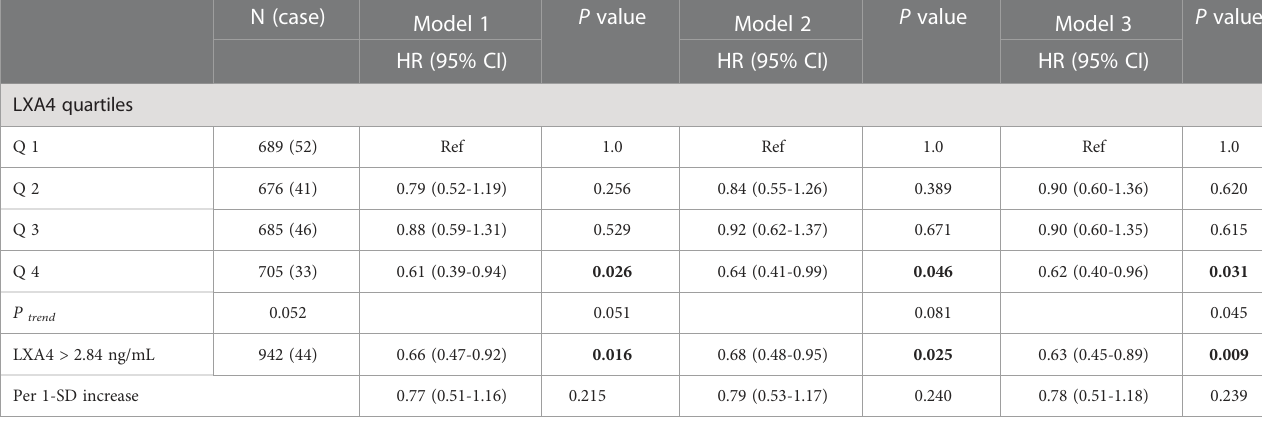
TABLE 2 Association between LXA4 and the incidence of T2DM. N (case)